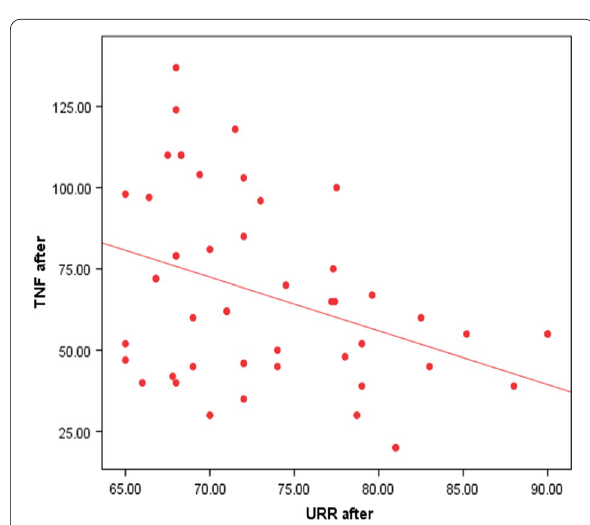
Fig. 3 Negative correlation between TNF‑α and